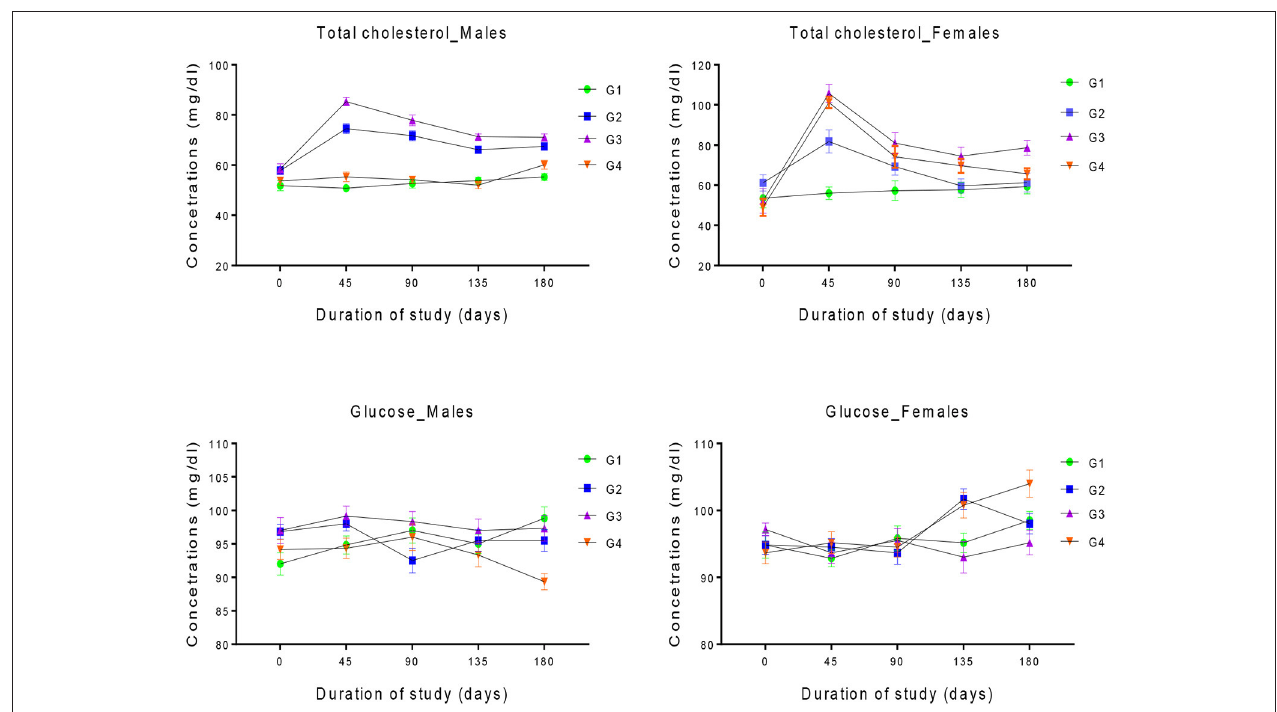
FIGURE 3 | Changes in the levels of serum total cholesterol and Glucose in the four experimental groups of male and female rabbits. group. G1 control group, G2, G3, and G4 represent 20, 30, and 40% GM cottonseed respectively. Two-way ANOVA indicated significant differences between groups, sampling periods and their interaction ( P < 0.05). Post-hoc multiple comparisons further revealed significant differences between specific treatment groups and the control groups.